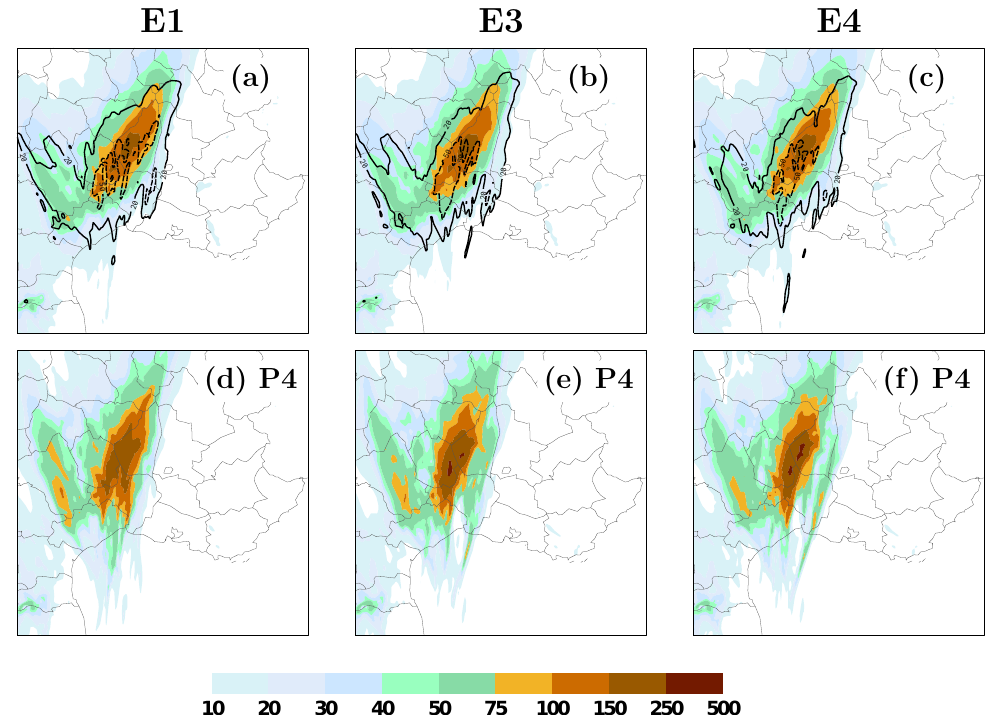
Fig. 6. 24-h accumulated precipitation forecasts (mm) for Case 3, at 12:00 UTC 2 November 2008. (a–c) Ensemble mean (colour shading) and standard deviation (solid contour: 20mm, dashed contour: 50mm), and (d–f) precipitation forecast by member 4, from the E1 (left), E3 (centre) and E4 (right)